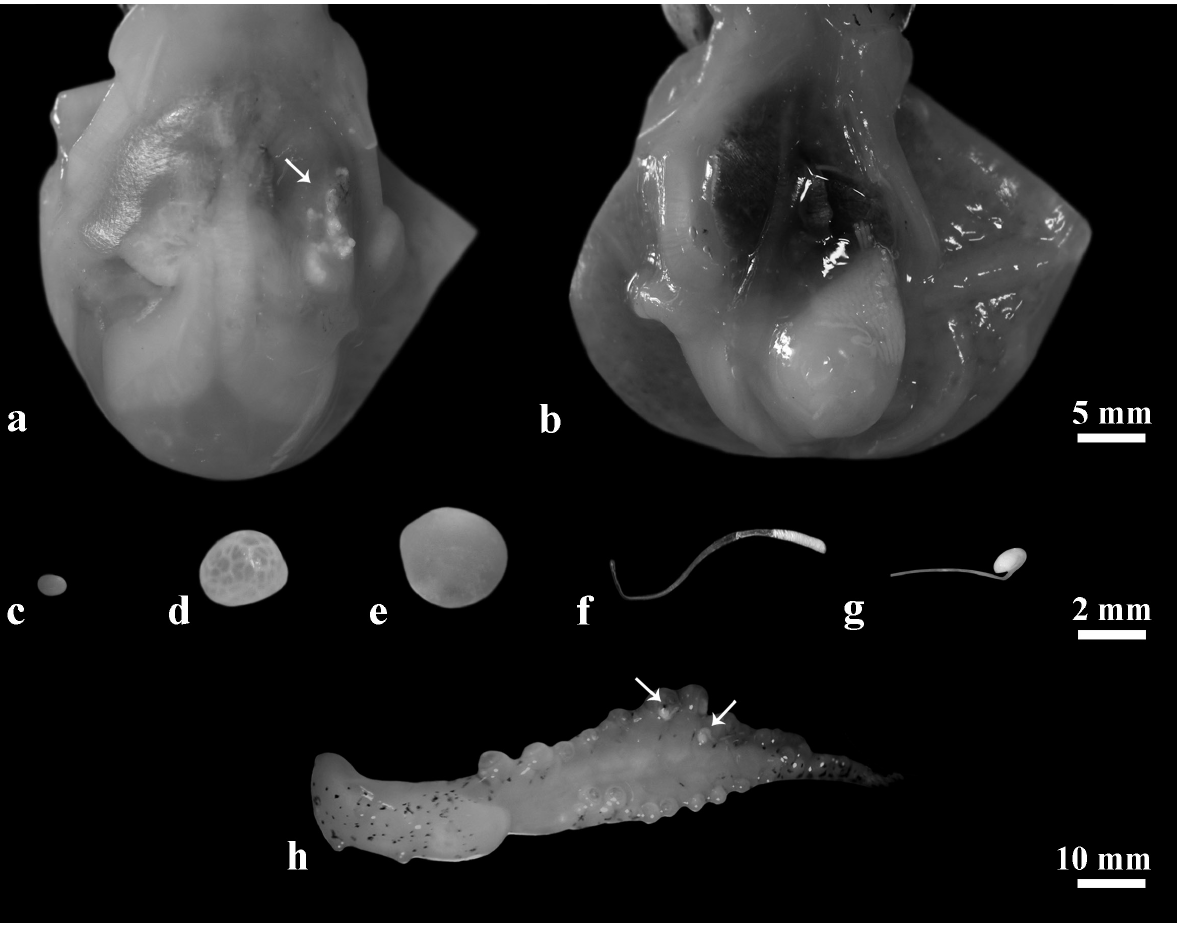
Fig . 2. – Sepietta oweniana from Sardinian waters: female (a) and male (b) reproductive system, fresh material. Small (c), reticular (d) and ripe (e) oocytes. Spermatophores (f), spermatangium (g) and hectocotylus (h). The arrow in (a) shows spermatangia inside the copulatrix bursa and the arrows in (h) indicate spermatangia imbedded in the